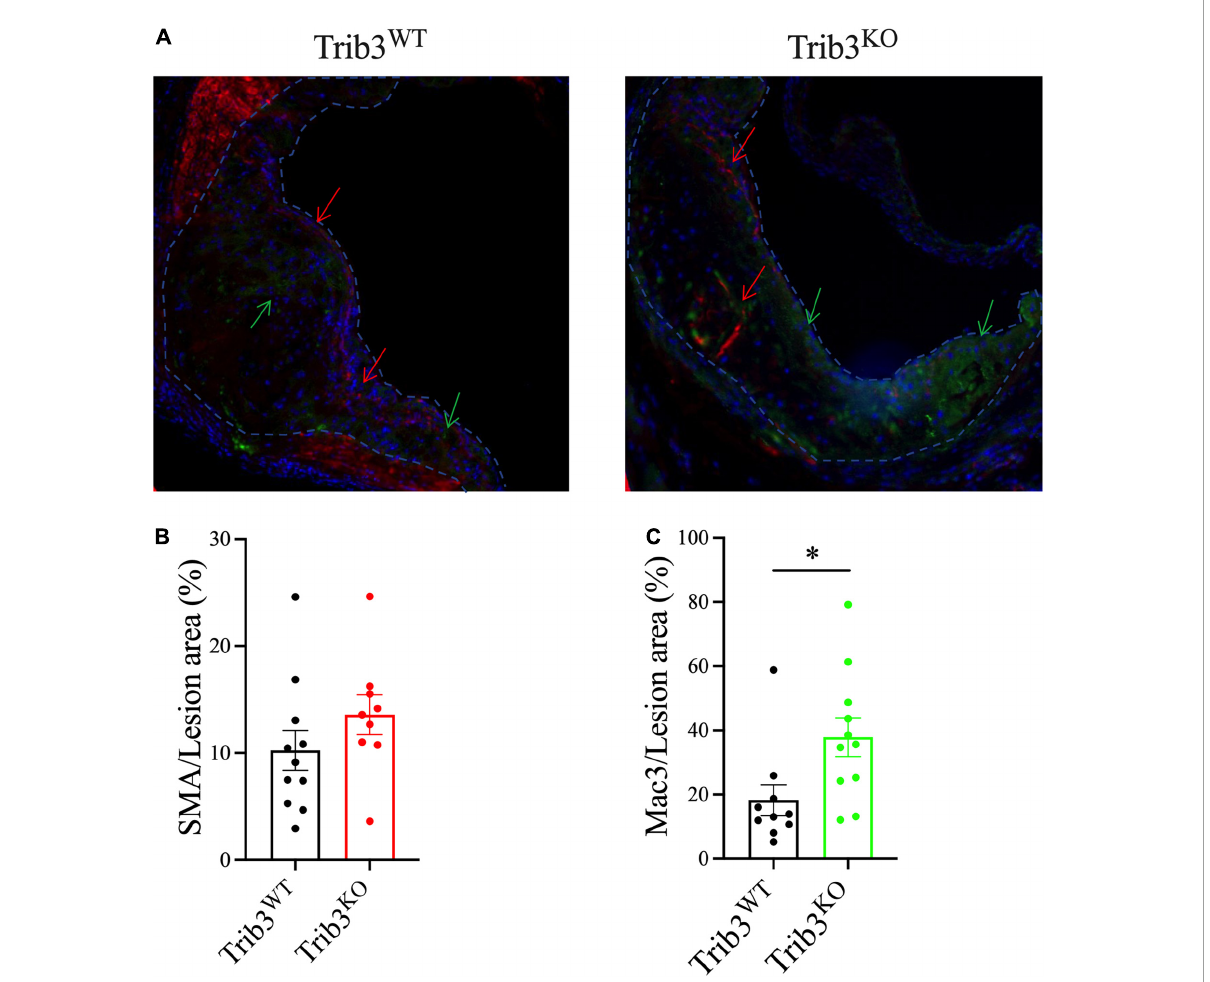
FIGURE4 Genetic deletion of Trib3 has no effect on SMC content but increases macrophage presence in advanced atherosclerotic lesions with altered ECM degradative function. (A) Representative images of α -SMA (red) and MAC-3 (green) staining of aortic root lesions from Trib3 KO and Trib3 WT mice. DAPI (blue) was used as a marker for nuclear staining. Quantification of the SMC area (B) and macrophage area (C) immunostaining as a percentage of the total lesion area. Graphs are shown as the mean ± SEM; each data point represents a lesion ( n = 9–10 lesions from N = 6 mice for each group). Unpaired t -test, ∗ p <